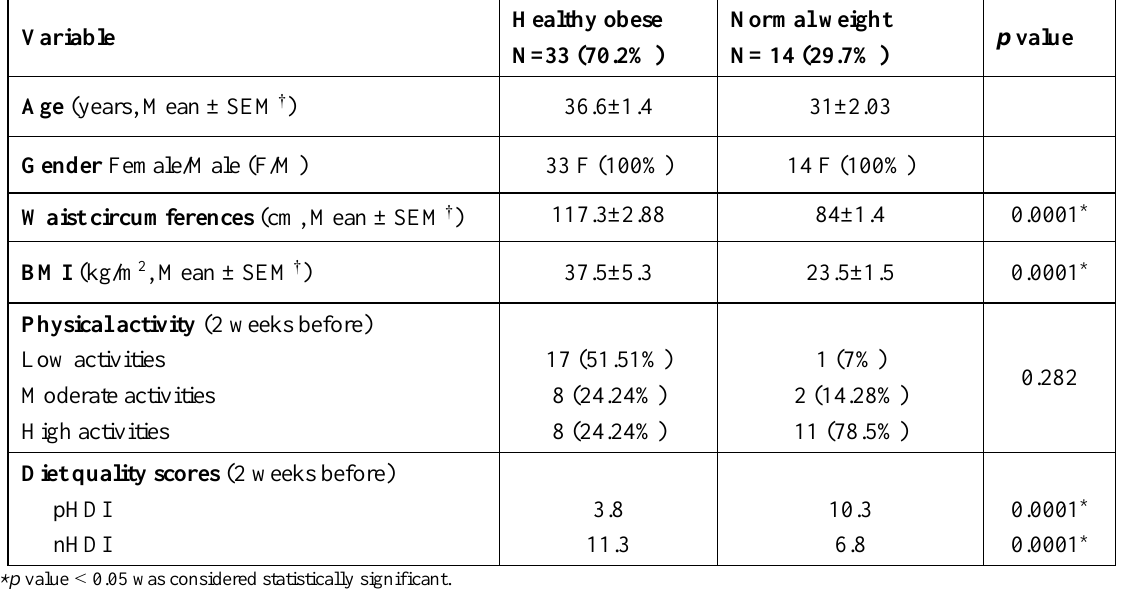
Table 2. Demographic data, anthropometric measurements, physical activity and diet quality scores of the study participants.